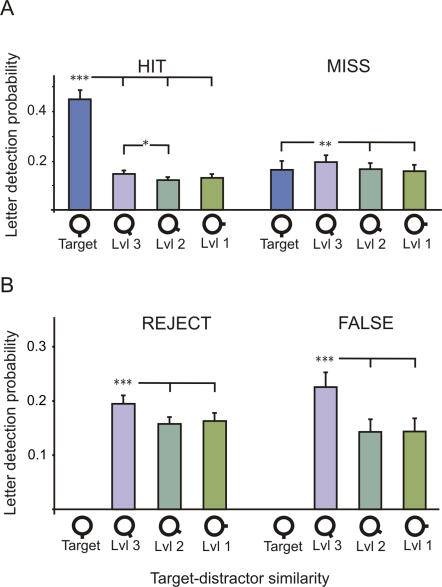
Effect of target-distractor similarity on letter detection performance.A. Main effect of target-distractor similarity on “target present” trials for HIT (left) and MISS (right) trials. In the HIT trials, letters located inside the target were more likely to be detected than other letters, whereas this effect was reversed in the MISS trials. In both types of trials, letters located in level 3 distractors were more often detected than those located in level 2 and level 1 distractors (*: p<0.01; **: p<0.001; ***: p<0.0001). Y axis: percentage of letter detection. X axis: target-distractor similarity varying from 4 (target) to 1 (most dissimilar distractor). Error bars correspond to standard errors. B. Main effect of target-distractor similarity on “target absent” trials for REJECT (left) and FALSE ALARM (right) trials. In both types of trials, letters located in level 3 distractors were more likely detected than those located in level 2 and level 1 distractors. Same conventions as in A.